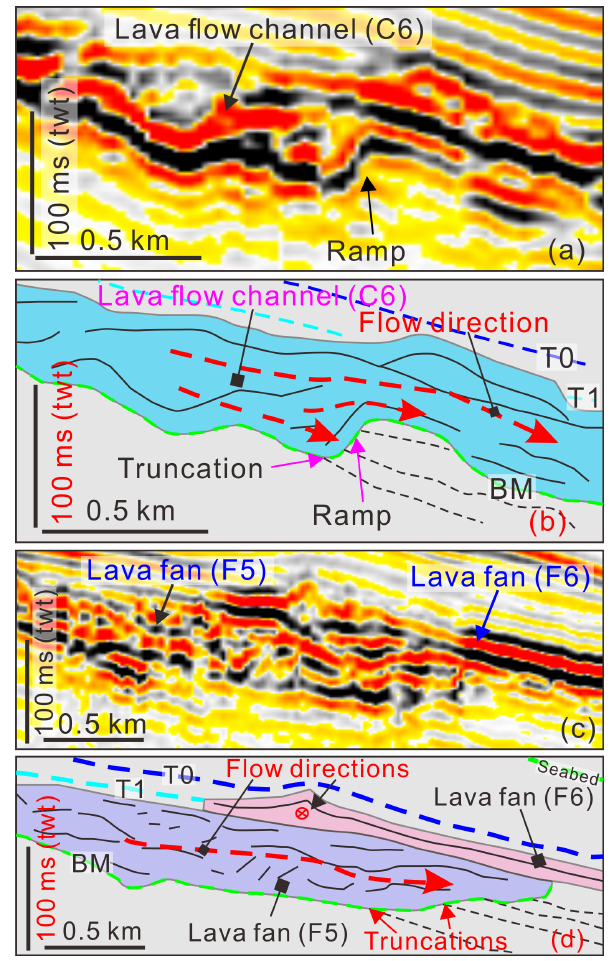
Figure 8. (a, b) Enlargement of the end of lava flow channel (ramp structure) and its line drawings; (c, d) enlargement and its line draw- ings of the lava fans (F5 and F6). BM – base of volcano–lava flow. See locations in Fig.